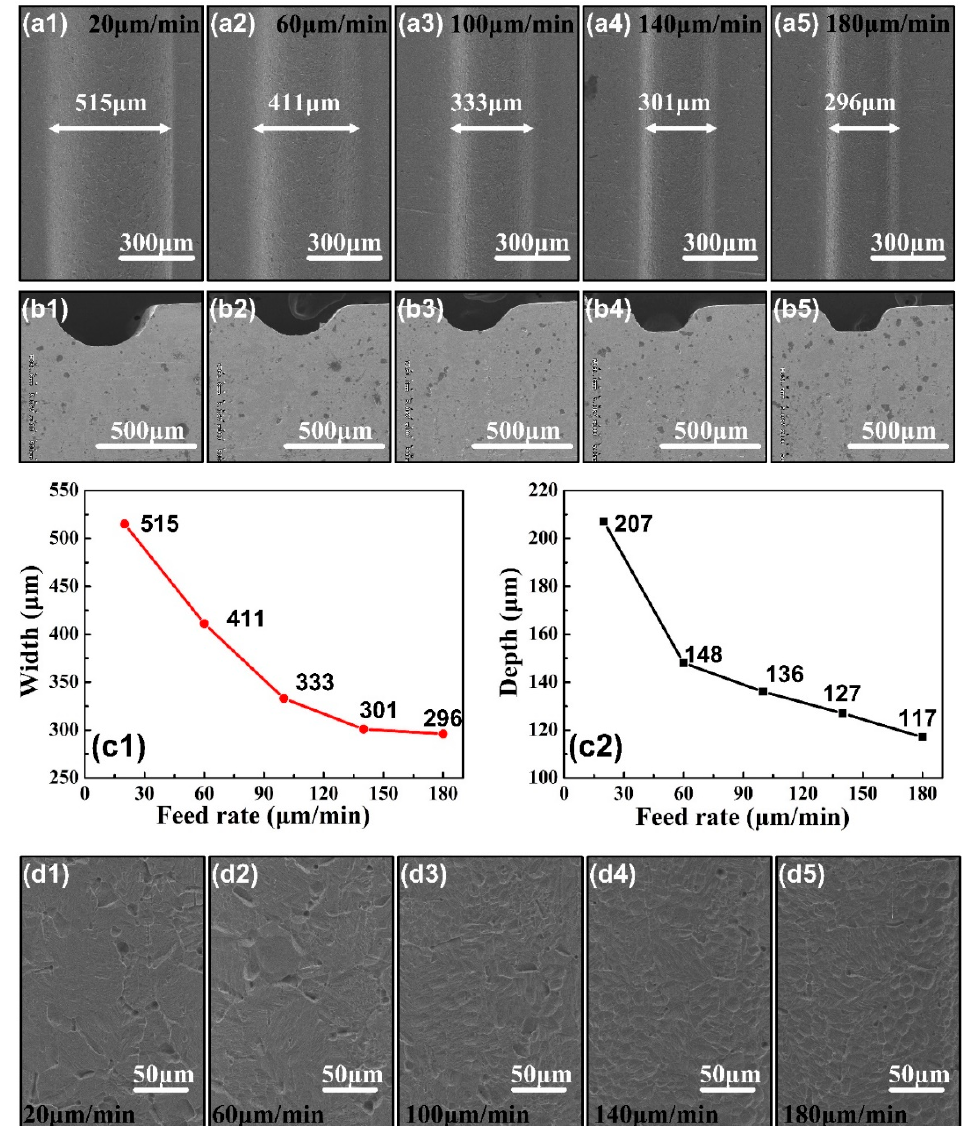
Figure 6. ( a1 – a5 ) SEM images of the morphology on micro-grooves under the feed rates of 20 μ m/min, 60 μ m/min, 100 μ m/min, 140 μ m/min and 180 μ m/min. ( b1 – b5 ) The cross-profiles of the micro-grooves under corresponding feed rates. ( c1 , c2 ) The width and depth of the micro-grooves changing curves with feed rates. ( d1 – d5 ) The surface quality of the micro-grooves under corresponding feed rates.